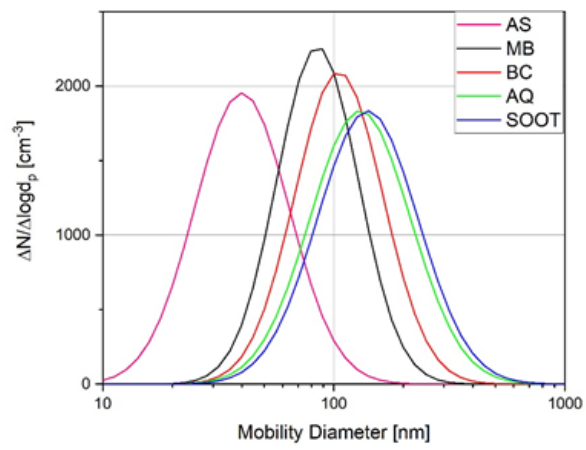
Figure 2. Measured size distributions by SMPS for the pure aerosol types used, normalized to an assumed total concentration. Figure 3. Scatter plots of the extinction coefficients for different